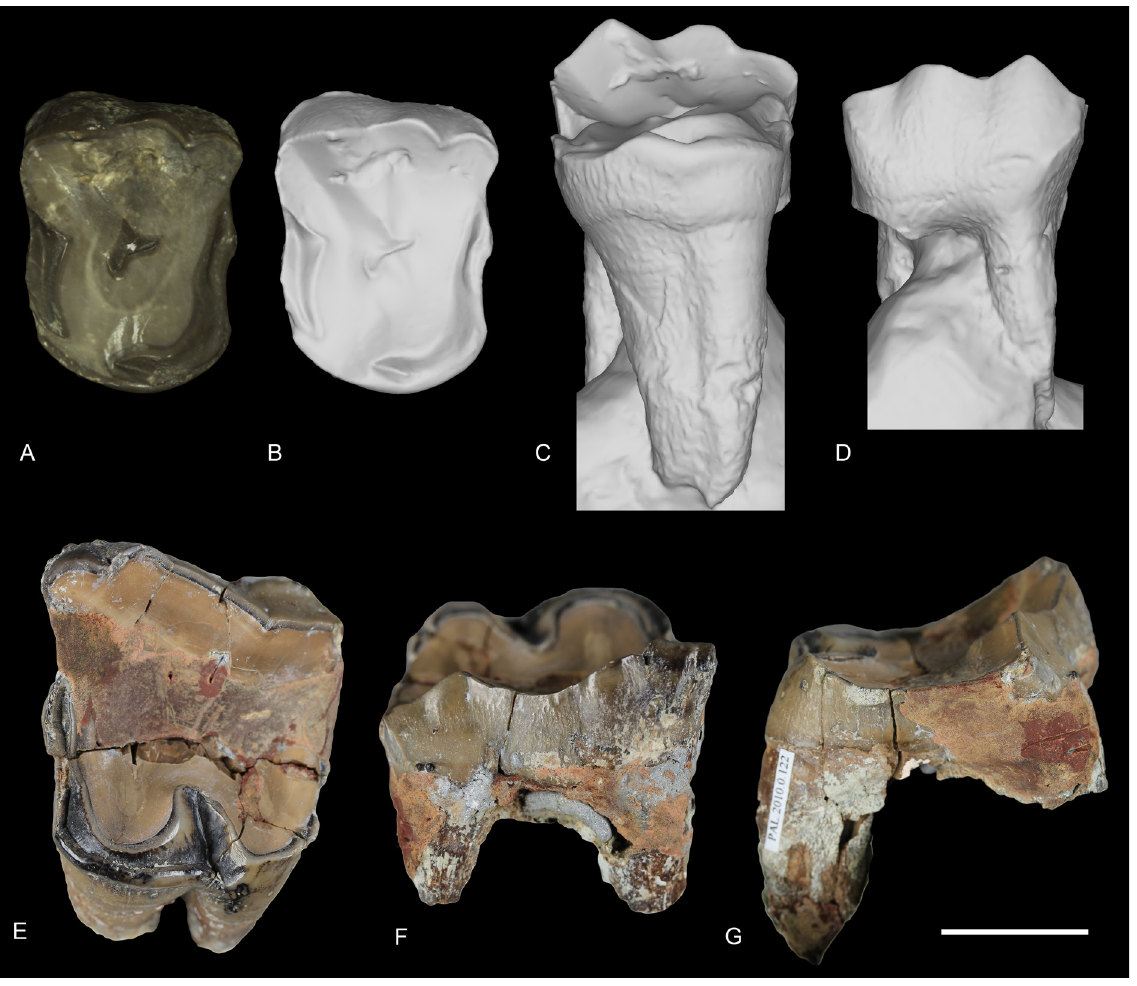
Fig. 3. Ronzotherium velaunum (Aymard in Pictet, 1853) from Ronzon (earliest Oligocene, France). – A–D . 3D surface scans of P3 PUY.2004.6.1767.RON. A . With texture in occlusal view. B . Without texture in occlusal view. C . Without texture in lingual view. D . Without texture in labial view. – E–F . M1 TLM.PAL.2010.0.122. E . Occlusal view. F . Labial view. G . Lateral view. Scale bar: 2